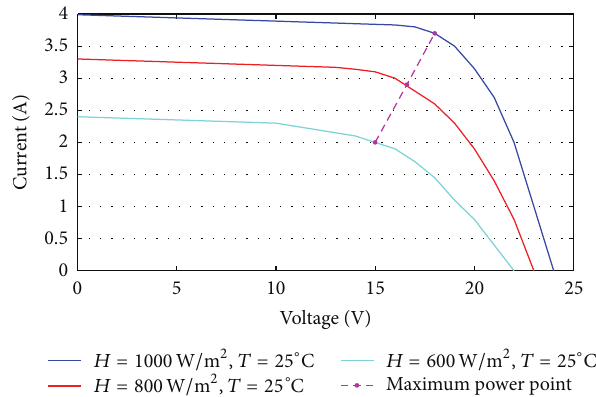
Figure 2: I-V characteristics of KC65T PV module at various irra- diance